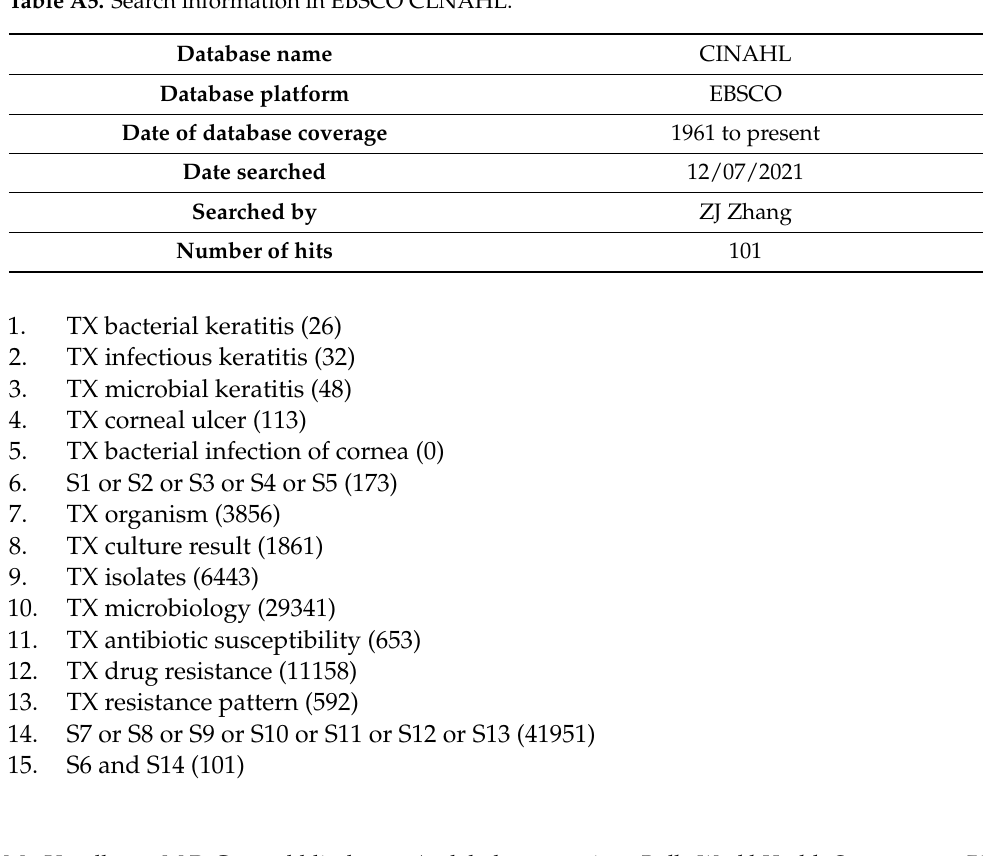
Table A5. Search information in EBSCO